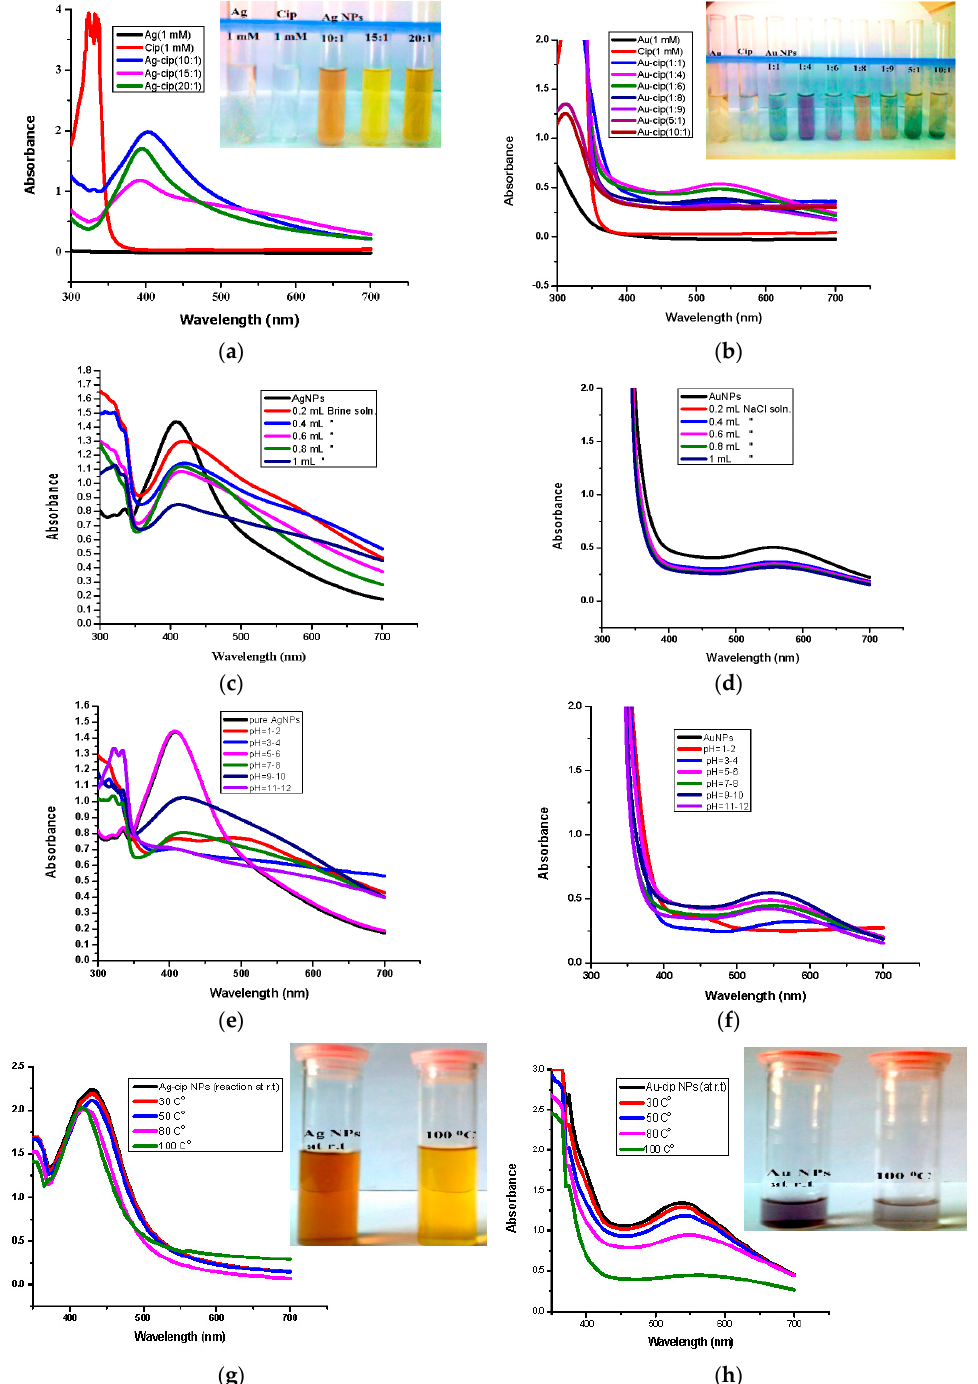
Figure 2. ( a ) Optimized UV-Vis spectra of Ag-cip NPs (Inset: Ag-cip NP color); ( b ) Optimized UV-Vis spectra of Au-cip NPs (Inset: Au-cip NP color); (c) Effect of salt on the stability of Ag-cip NPs; ( d ) Effect of brine on the stability of Au-cip NPs; ( e ) Effect of pH on the stability of Ag-cip; ( f ) pH effect on the stability of Au-cip; ( g ) Effect of temperature on the stability of Ag-cip NPs. (Inset: effect of temperature on Ag-cip NP color; ( h ) temperature effect on the stability of Au-cip NPs. (Inset: effect of temperature on Au-cip NP color).